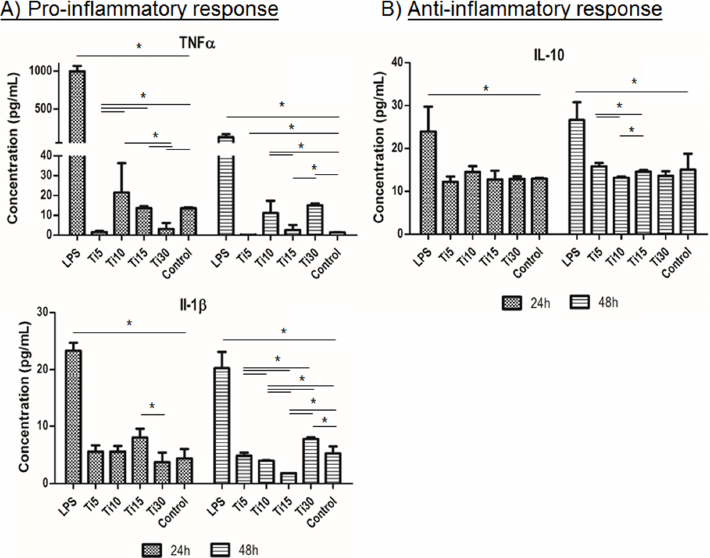
Figure 5. Immune response cytokine analysis. Cytokine release analysis of the inflammatory response in THP-1 cells from proinflammatory markers TNF α and IL-1 β ( A ) and anti-inflammatory marker IL-10 ( B ). Cultured cells with extracts of titanium microparticles at 5 μ m, 10 μ m, 15 μ m, and 30 μ m were analyzed at 24 h and 48 h. LPS was used as a positive control of inflammation, while medium without particles was used as a negative control. * p < 0.05.